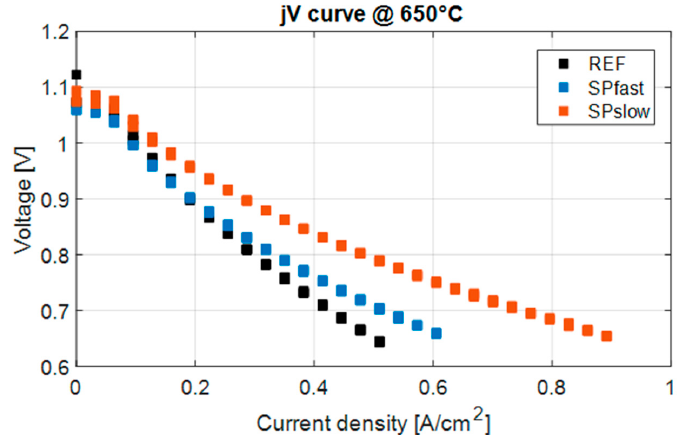
Figure 6. jV curves of samples REF (black markers), SPfast (blue markers), and SPslow (red markers) measured at 650 °C.